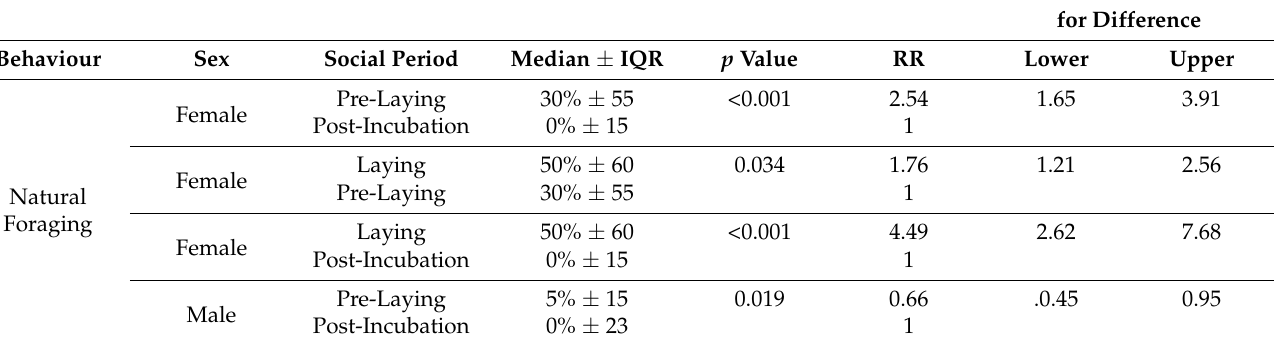
Table 3. Output of Generalised Estimating Equations including the Rate Ratios (RR) with 95% Confidence Intervals for female and male Mandarins for “Natural Foraging” during different Social